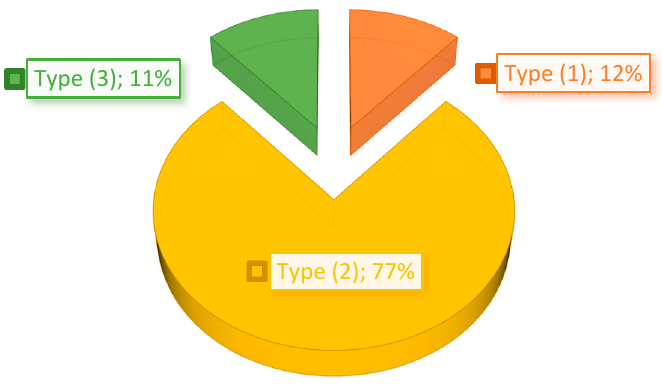
Figure 2. Share of different types of multi-objective optimization (MOO) in the core literature.